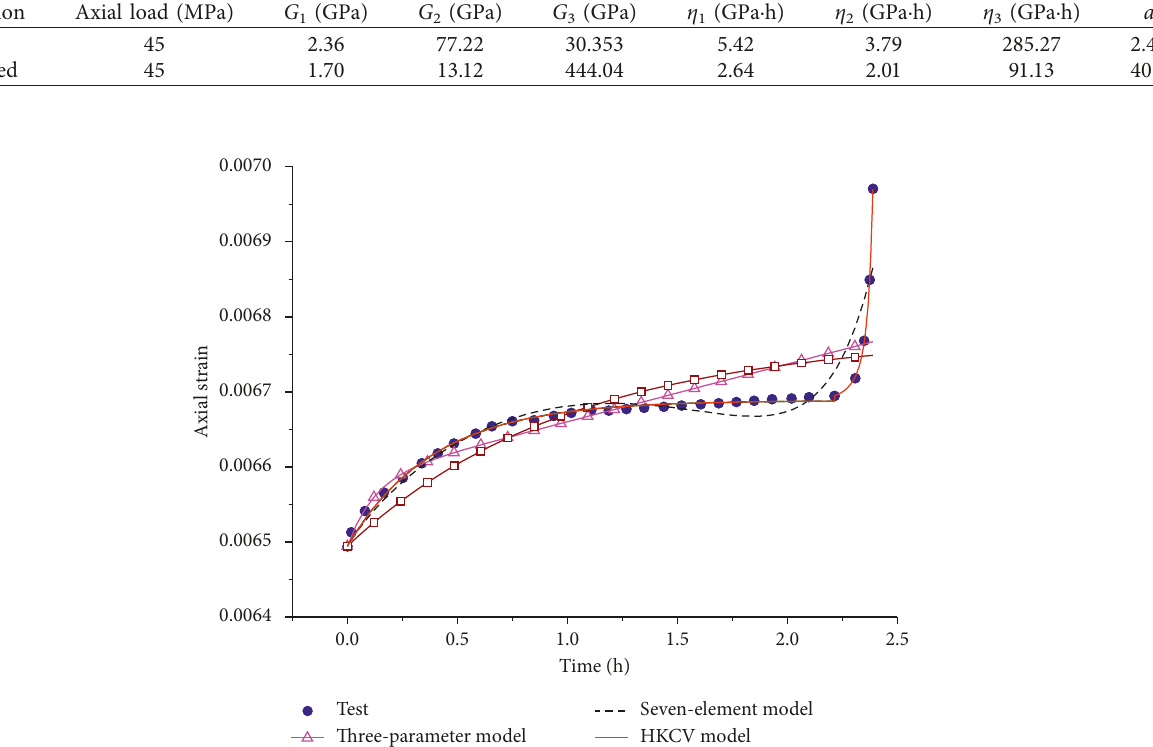
1 (cid:31) 45 MPa).